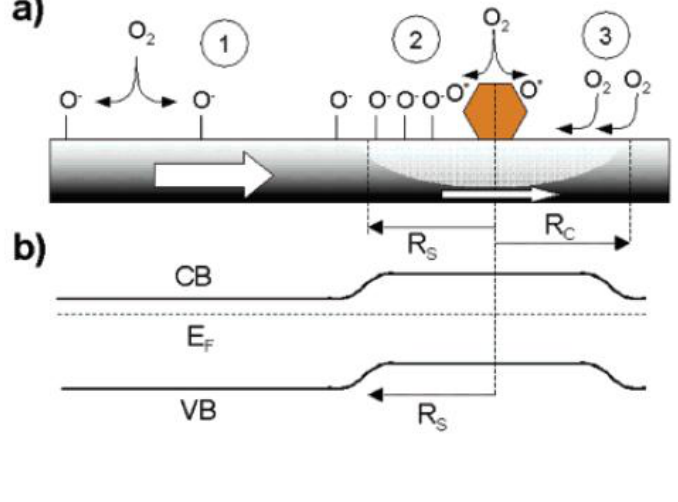
Figure 6. (a) Schematic depiction of the major process taking place at a SnO nanowire/nanobelt surface when exposured to O nanostructure and in the vicinity (and beneath) a Pd nanoparticle. The radius of the depletion region is determined by the radius of the spillover zone (adapted from